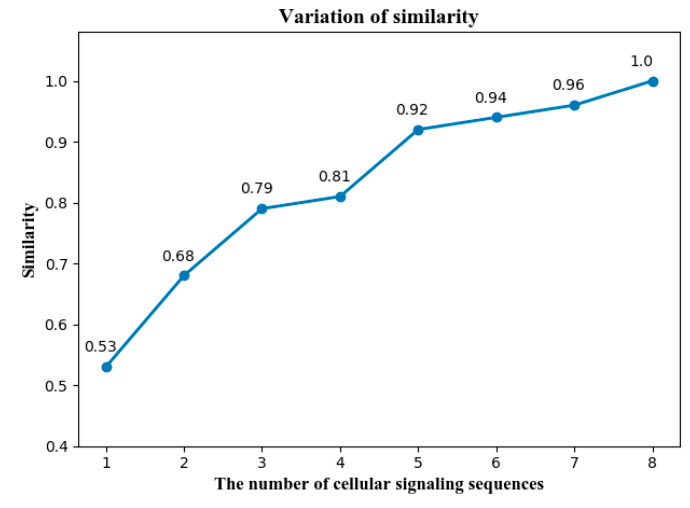
Figure 9. The variation of SBSS under different numbers of cellular signaling sequences.